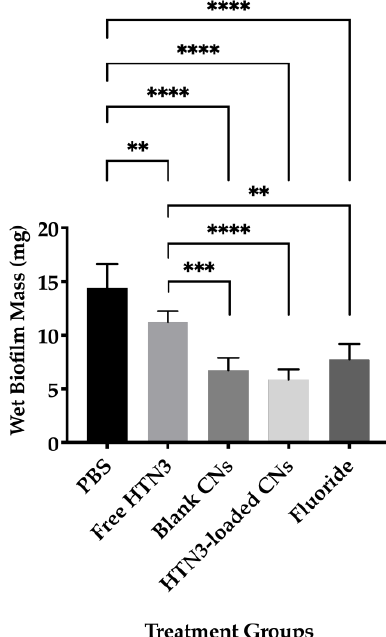
Figure 5. Protein degradation over time for free HTN3 and HTN3-loaded into CNs. For free HTN3, most protein was degraded in 2 h. At the same time point, about half of HTN3 was still intact in the CNs delivery system. The dashed line represents the degree of protection offered through CNs encapsulation.